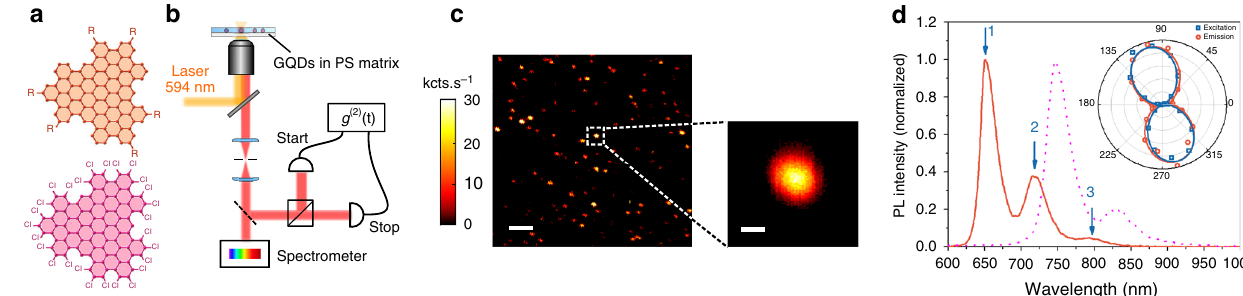
Fig. 1 Photoluminescence of single GQDs. a Chemical structure of the C 96 and C 96 Cl GQDs. R stands for C 12 H 25 . b Scheme of the microphotoluminescence setup. c 20 × 20 μ m 2 PL map of the C 96 GQDs in polystyrene matrix. The color bar represents the number of counts per second on the APD. The scale bar is 3 μ m. The zoom shows a diffraction limited spot that can be fi tted with a 2D Gaussian function leading to a 1/e 2 diameter of ∼ 600 nm. The scale bar is 200 nm. d Room temperature PL spectra of a single C 96 GQD (solid line) and of a single C 96 Cl GQD (dotted line). Polarization diagram in excitation (blue) and emission